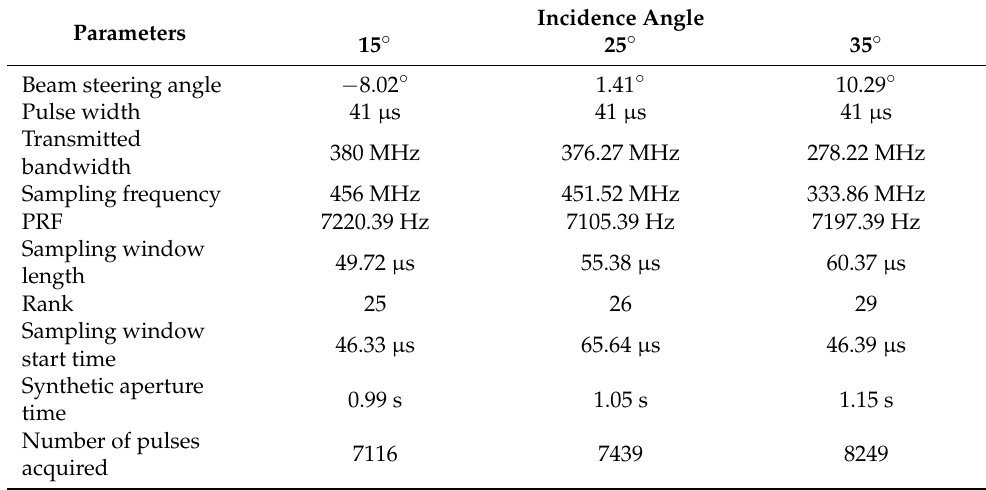
Table 4. Operational parameters of the S-STEP SAR payload in the high-resolution mode.